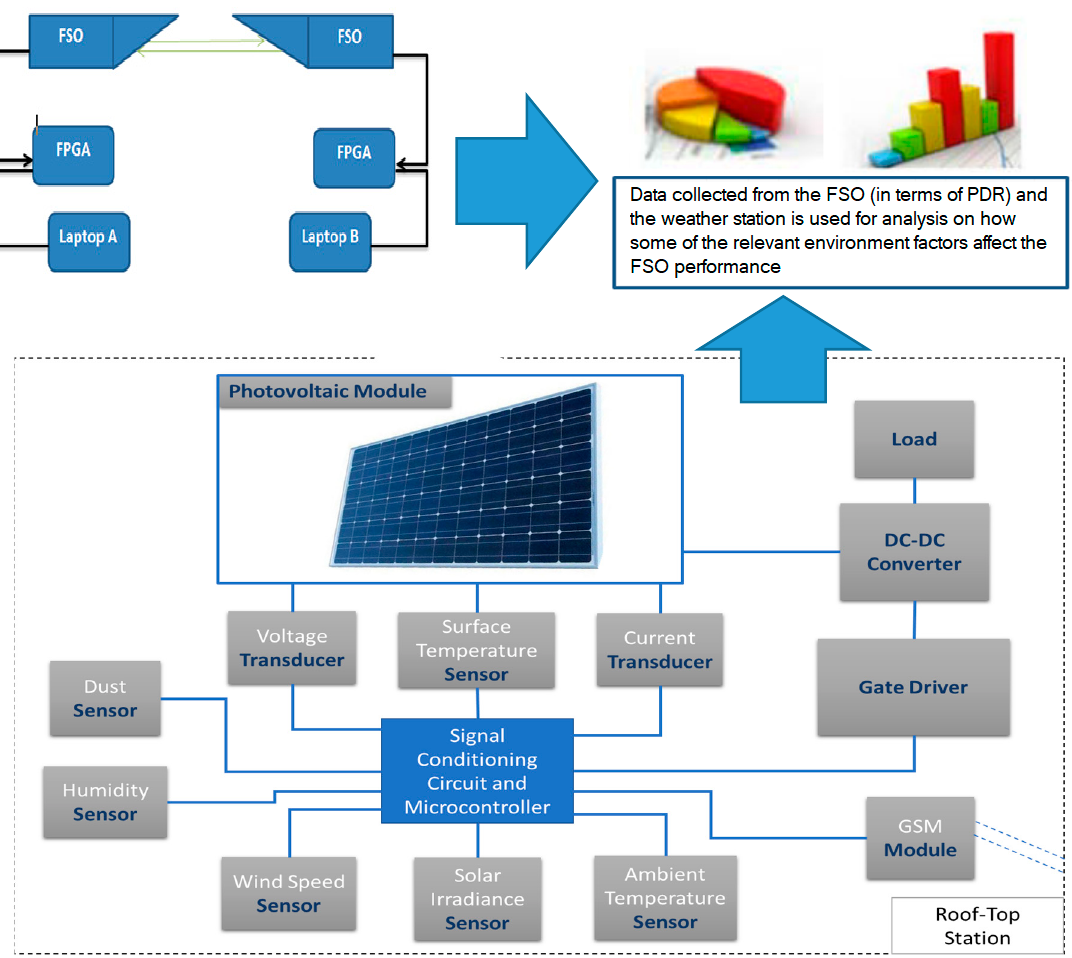
Figure 2. Diagram to show how the data, collected from two systems, are used in analysis. PDR: Packet Delivery Ratio; FPGA: Field Programmable Gate Array.